Question: Based on the figure, does the quantity rise or fall?
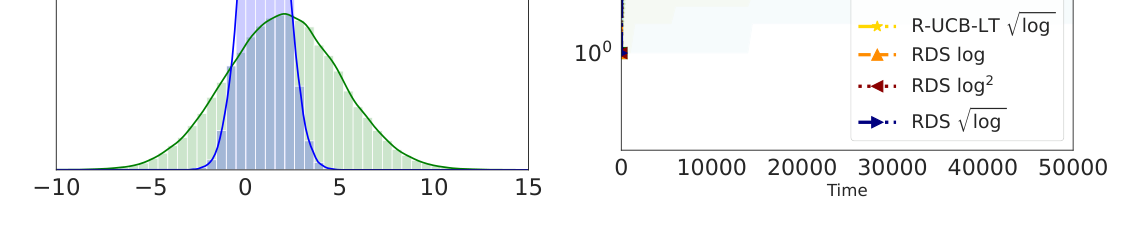
Answer: increasing